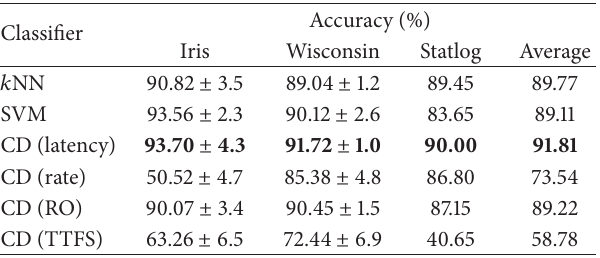
Table 5: Comparison of classification accuracy of several multivari- ate datasets using 𝑘 NN, SVM and CD